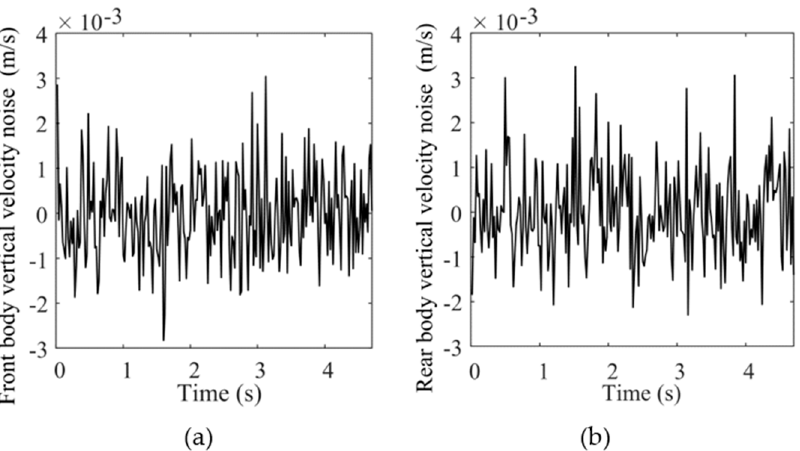
Figure 4. Body vertical velocity noises. ( a ) Front body vertical velocity noise; ( b ) Rear body vertical velocity noise.